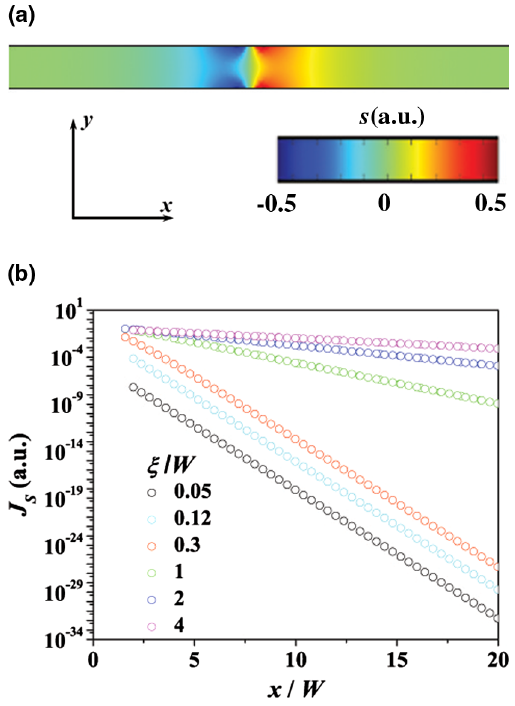
samples.FIG. 8. (a) The distribution of Berry curvature density s ð x; y Þ obtained by simulations using the COMSOL package. The decay length ξ is set to be ξ ¼ W . The color indicates the magnitude of FIG. 9. (a) Parameters f , λ and (b) coefficient α ð ξ Þ are plotted the Berry curvature density in arbitrary units. (b) The Berry as a function of ξ =W . The open symbols are simulation results, curvature current density J is plotted as a function of x . The S while the solid curves are from the analytical expression given in cases of ξ =W ¼ 0 . 05 , 0.12, 0.3, 1, 2, 4 are shown. In all cases, J S Ref. [11]. The simulation results and the predictions of the is seen to decay exponentially with x analytical expression agree well in the range ξ ≫ W , but they differ when ξ ≤ W . The latter applies to our